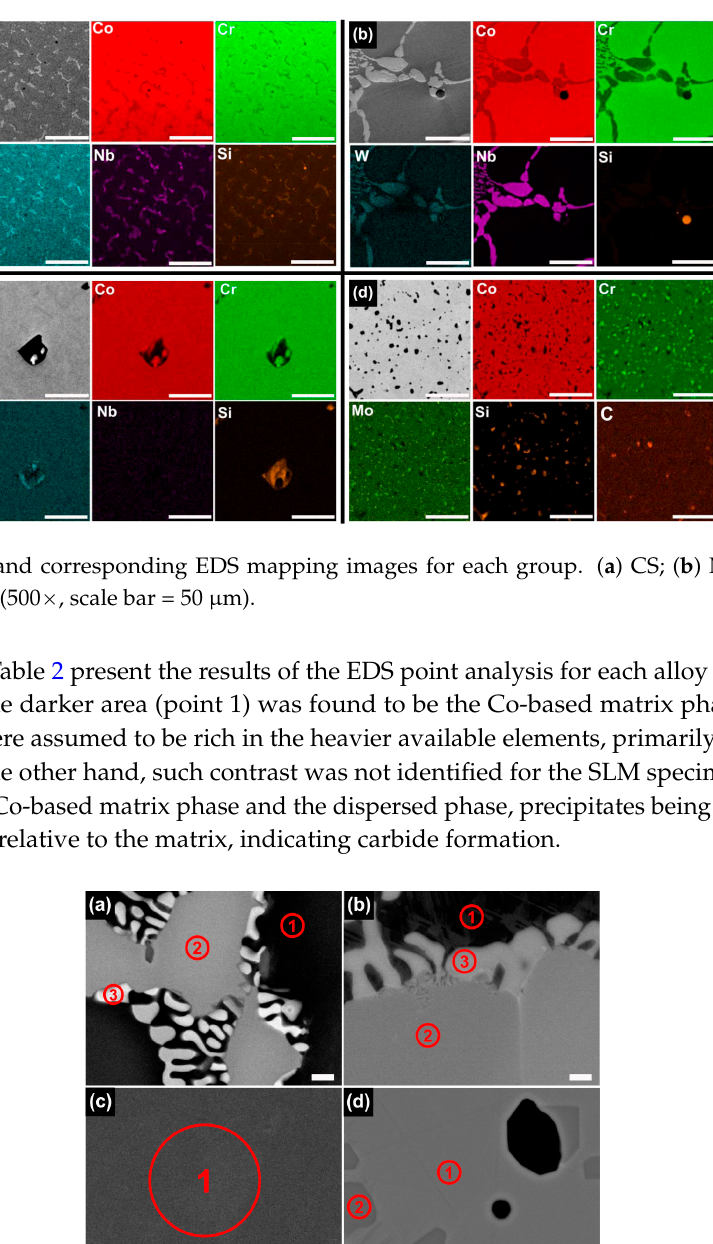
Figure 5. BSE images of the Co-Cr alloys for EDS point analysis. ( a ) CS; ( b ) ML; ( c ) SLM; and ( d ) ML/PS (10,000×, scale bar = 1 μ m). In each figure, the numbers indicate the points subjected to the EDS analysis. Table 2. Results of quantitative elemental point analysis (see Figure 5).